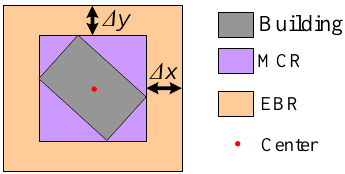
Figure 7. Region expansion for level-two segmentation.